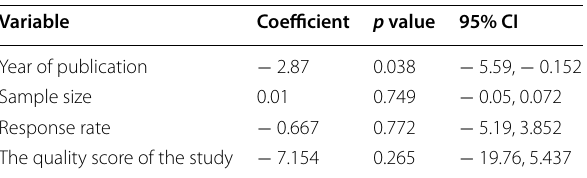
Table 2 Factors with the heterogeneity of food hygiene practice among food handlers in the current meta-analysis based on univariate